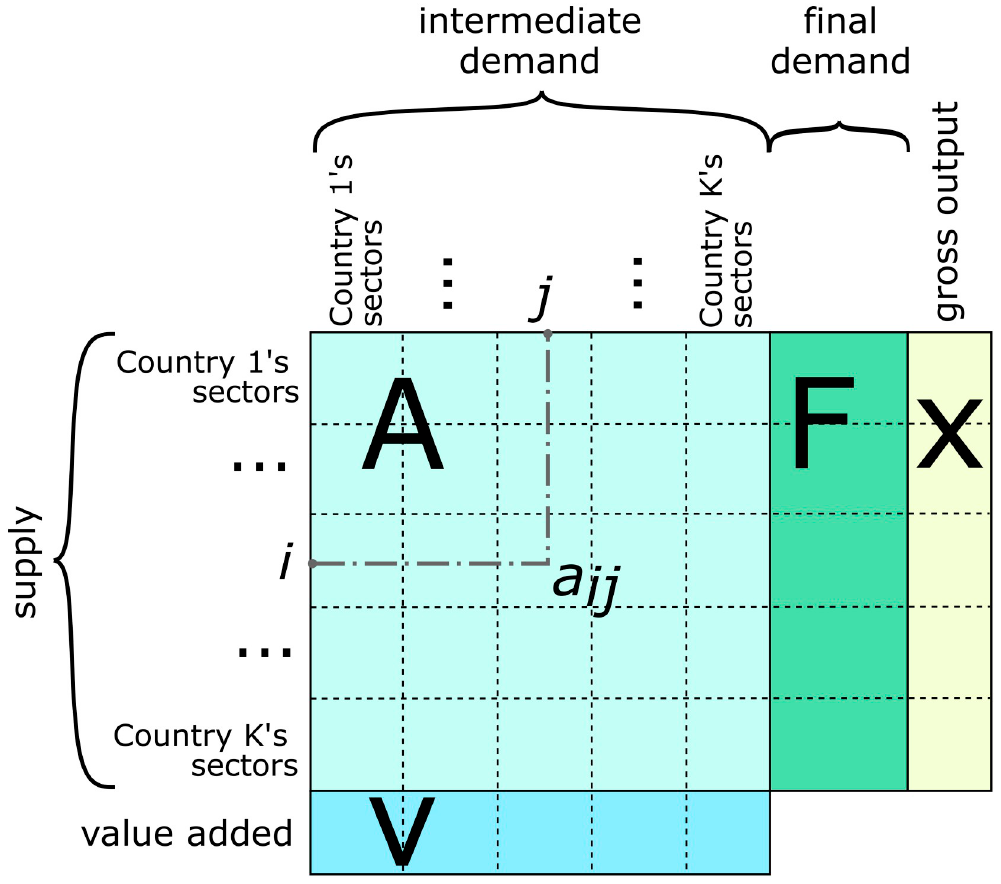
Fig 1. Structure of WIOD